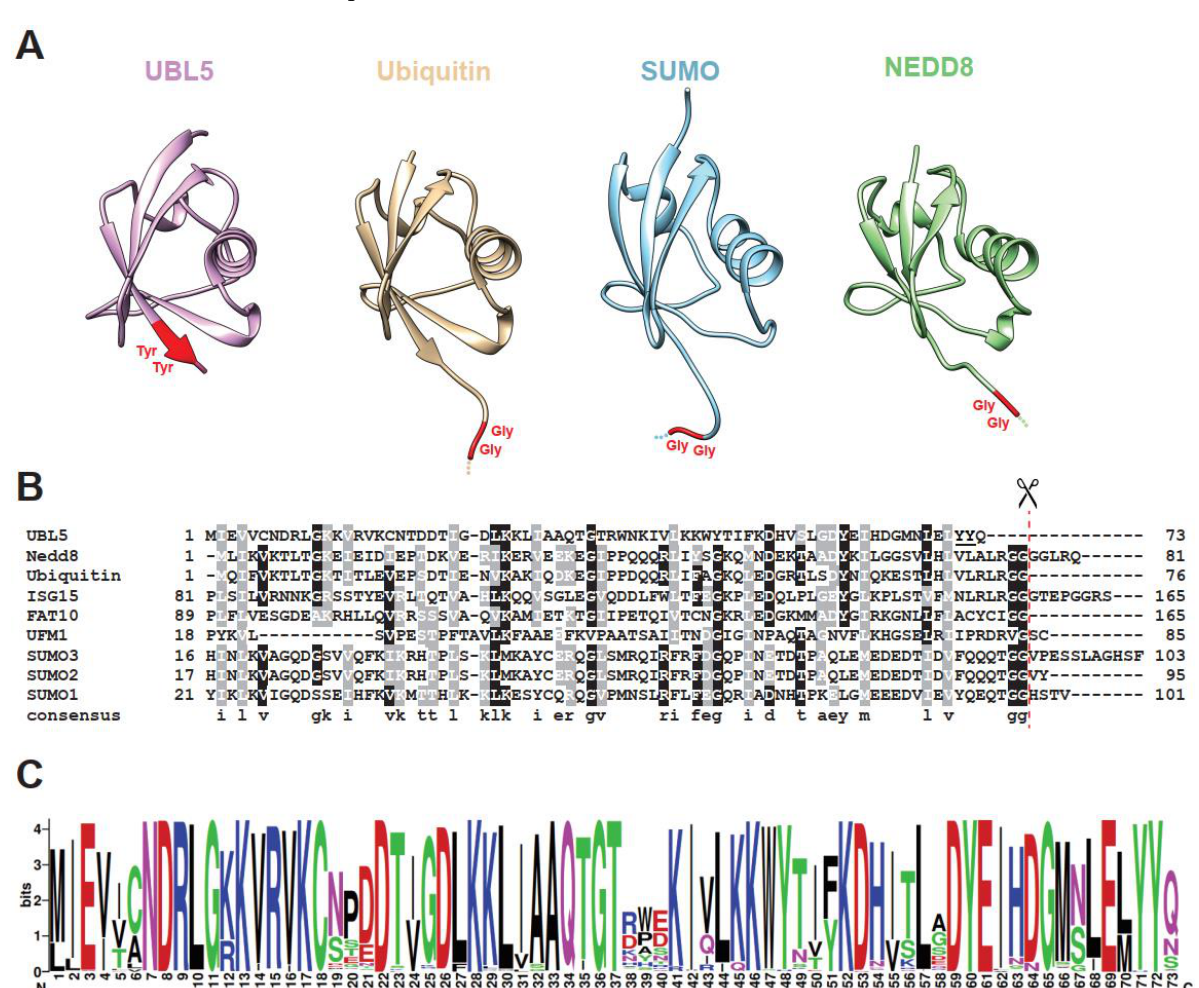
Figure 1. Three-dimensional structures and protein sequences of UBL5/Hub1 and other members of the ubiquitin family. ( A ) Structural ribbon representation of UBL5/Hub1 (PDB: 4PYU), ubiquitin (PDB: 1UBQ), SUMO-3 (PDB: 1U4A), and NEDD8 (PDB: 2N7K). C-terminal di-tyrosine motif of UBL5/Hub1 and di-glycine residues of others are highlighted in red. ( B ) Sequence alignment of human UBL5/Hub1 with ubiquitin and other ubiquitin-like proteins. The scissor symbol shows the processing site after the C-terminal di-glycine motif. The di-tyrosine motif of UBL5/Hub1 is underlined. ( C ) Weblogo [6] representation of the top 250 homologs identified by Blastp search using human UBL5 as query sequence [7]. The y -axis represents the bit score. Note that UBL5/Hub1 proteins in certain species carry a few amino acids that are extended from the N-terminus of the core ubiquitin-like domain; therefore, the sequence conservation at the first position is less than the maximum entropy of log 2 20 (4.32) bits [6].